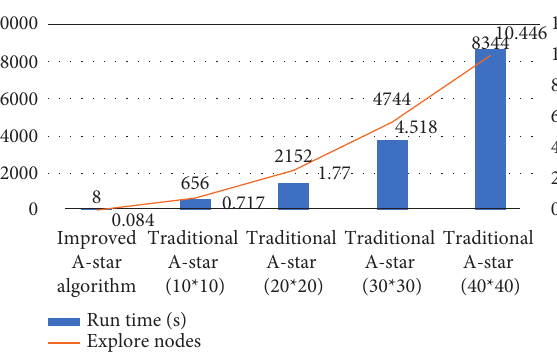
Figure 21: Comparison of the improved A-star algorithm and traditional A-star algorithm from Madrid to Cairo. Table 9: Comparison of the improved A-star algorithm and traditional A-star algorithm from Algiers to